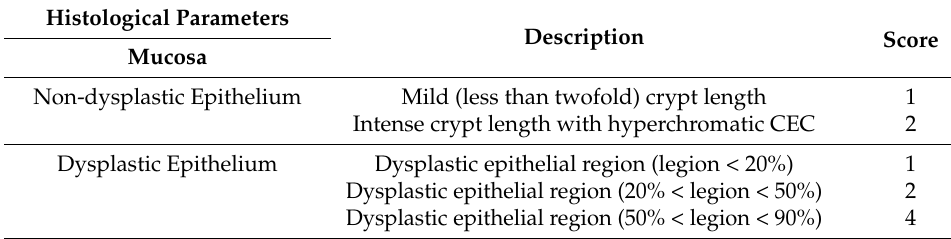
Table 2. Scores of histopathological hyperplasia.